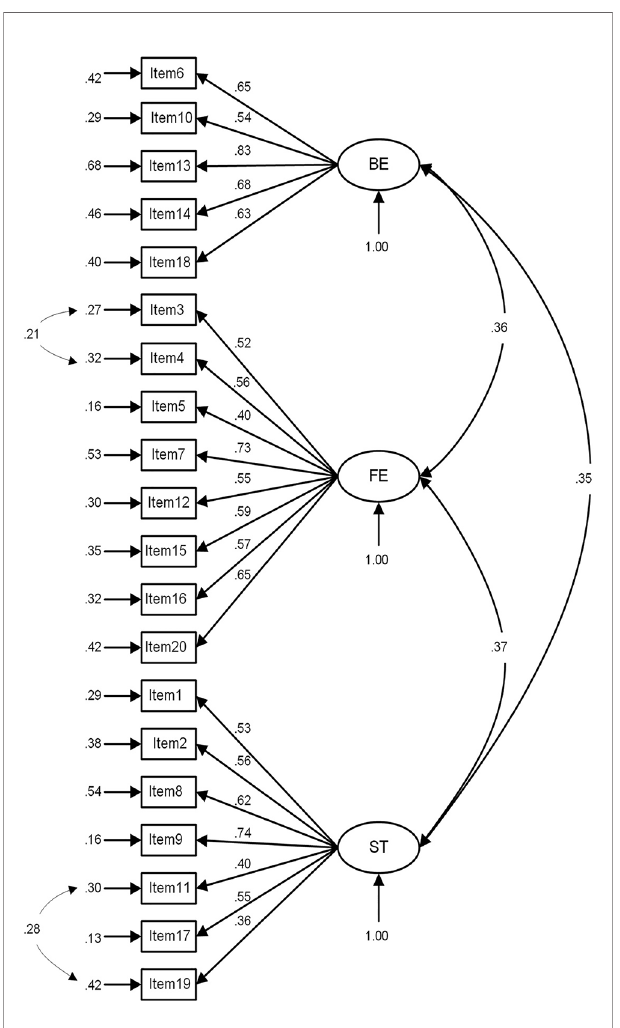
FIGURE 2 | The con fi rmatory factor analysis of the SF-CAMI in primary healthcare workers.